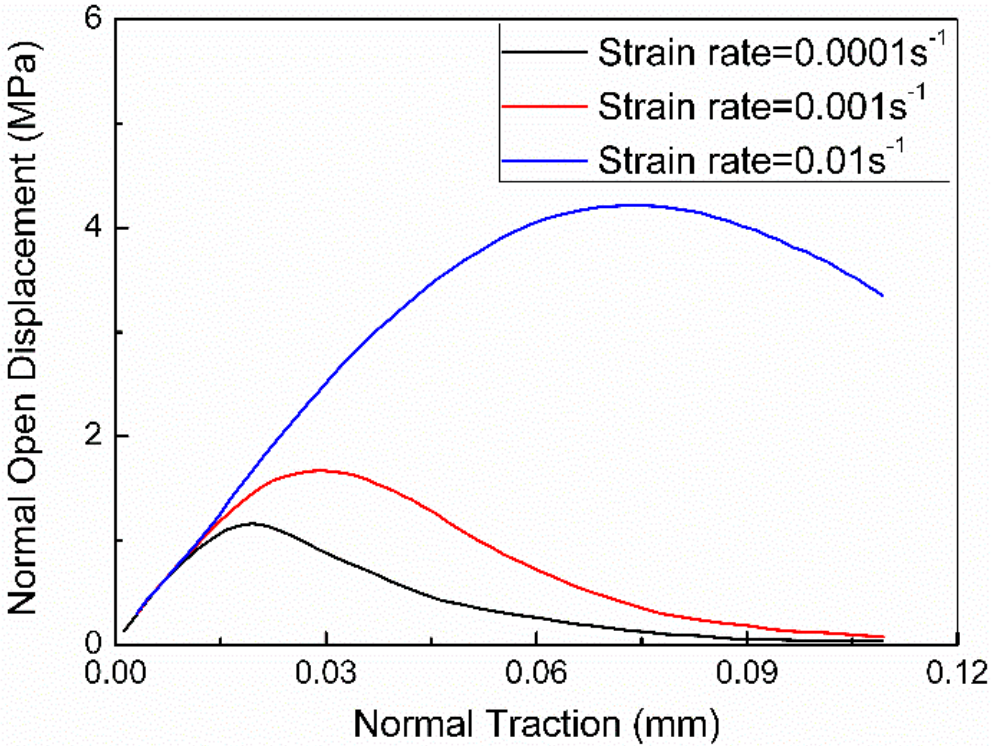
ff erent loading